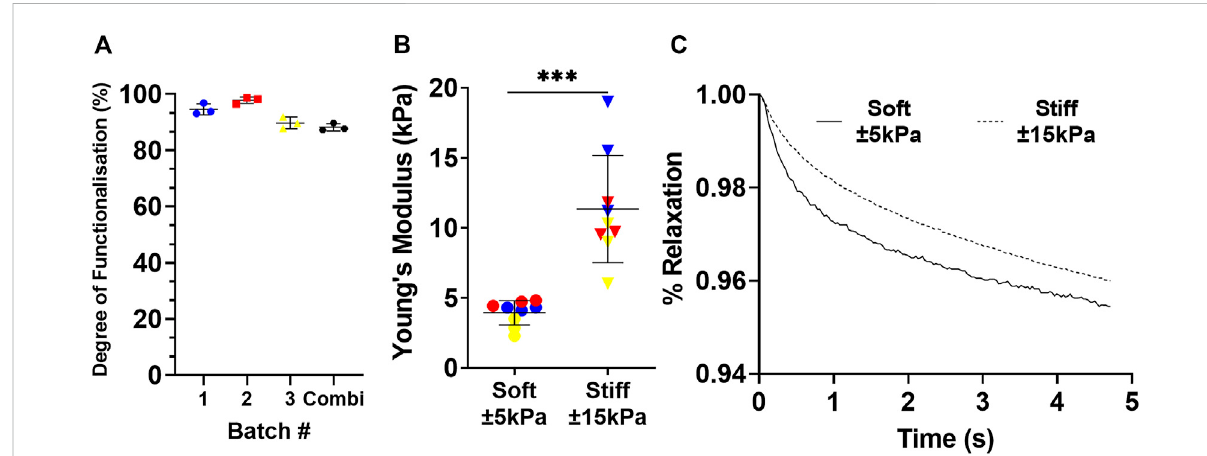
FIGURE 1 Mechanical properties of GelMA hydrogels. (A) Three different batches of GelMA were produced and the methacrylation ef fi ciency was measured to demonstrate minimal variety before being combined into one large batch. Each dot represents a technical replicate of a batch.